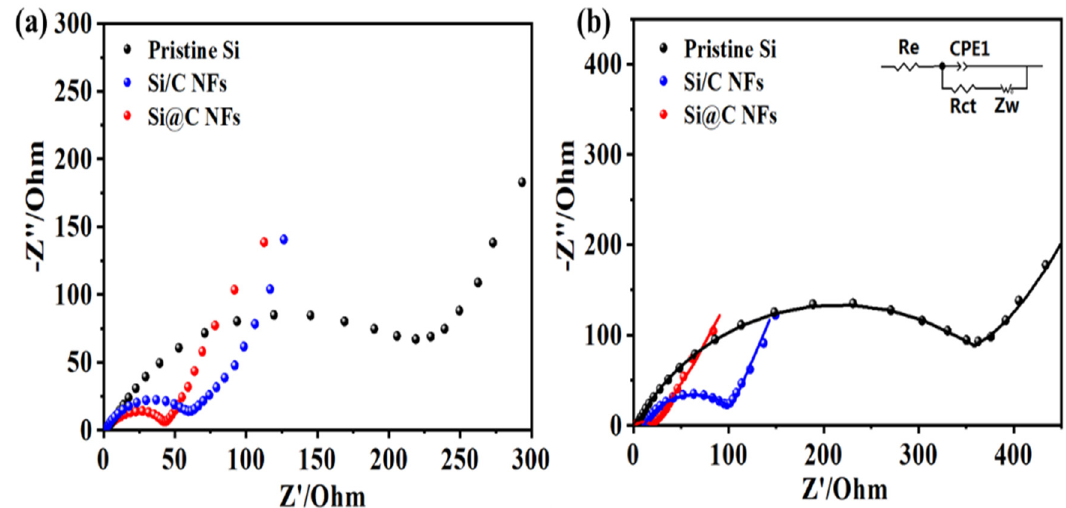
Figure 5. Nyquist plots for pristine Si NPs, Si/C NFs and Si@C NFs ( a ) before cycling and ( b ) after cycles (inset: equivalent circuit used to fit the experimental data).